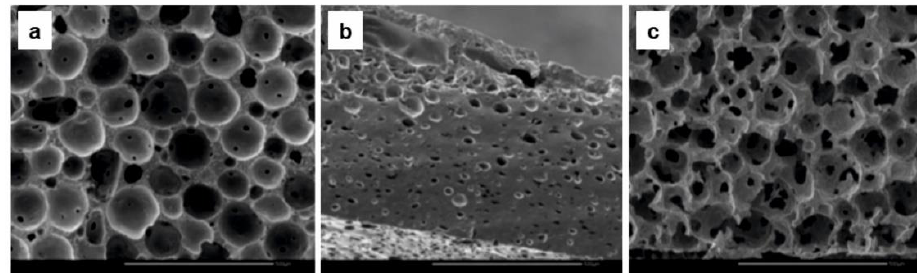
Figure 8. SEM images of preparation methods on elastomer scaffold structure: ( a ) scaffold made using only paraffin microbeads, ( b ) scaffold prepared using only water emulsified in the polymer solution,